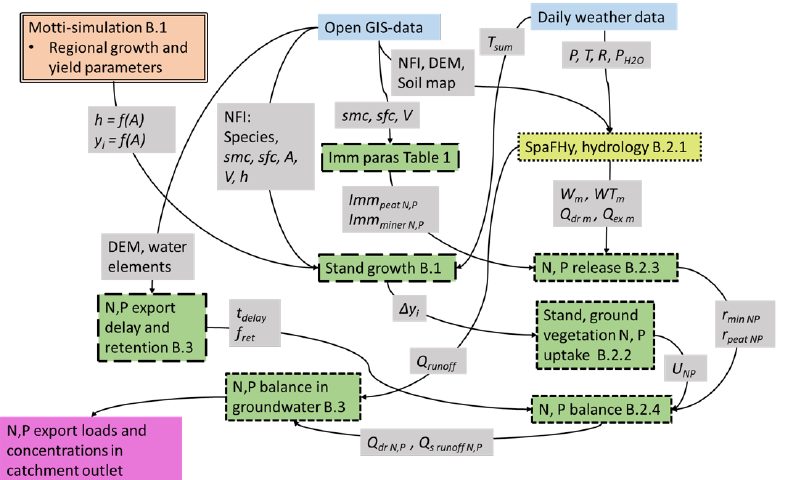
Figure 2. NutSpaFHy extends the hydrological model SpaFHy [30] (yellow box). Blue boxes refer to model inputs, orange box to a priori computation of regional forest growth parameters, green boxes are computation modules, grey boxes are variables or data transferred between the modules, and purple box is the model output. Outlines of the boxes describe the frequency of the computation: The box with double solid outline is computed a priori, boxes with a wide dashed outline are calculated only in the beginning of the simulation, and boxes with a square dotted outline are computed in monthly time-step. SpaFHy (yellow box) is calculated in daily time-step. Variable symbols are provided in Abbreviations. Symbols B.1...B.3 refer to Appendix B, where the sub- modules are described in